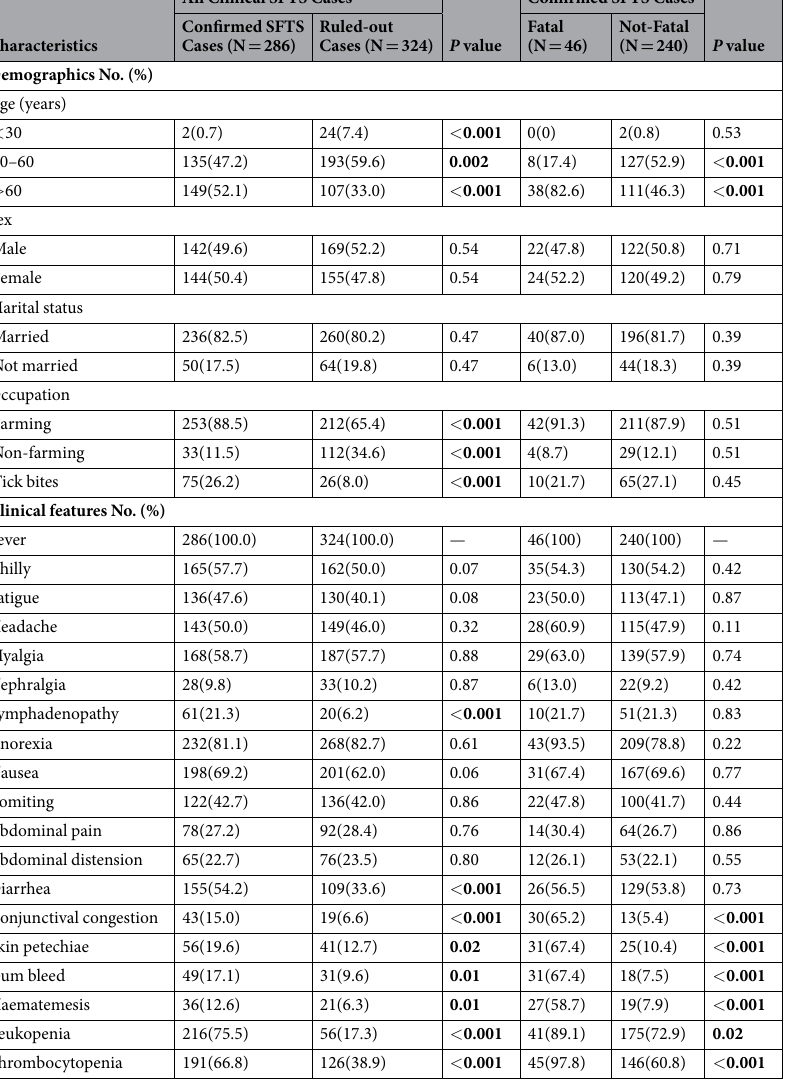
Table 1. Demographics and clinical features of confirmed and ruled-out cases with SFTSV infection in Eastern China,